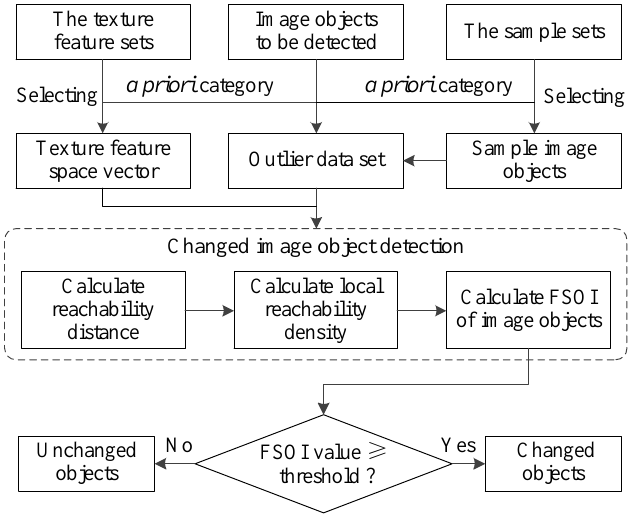
Figure 4. The process of changed object detection.